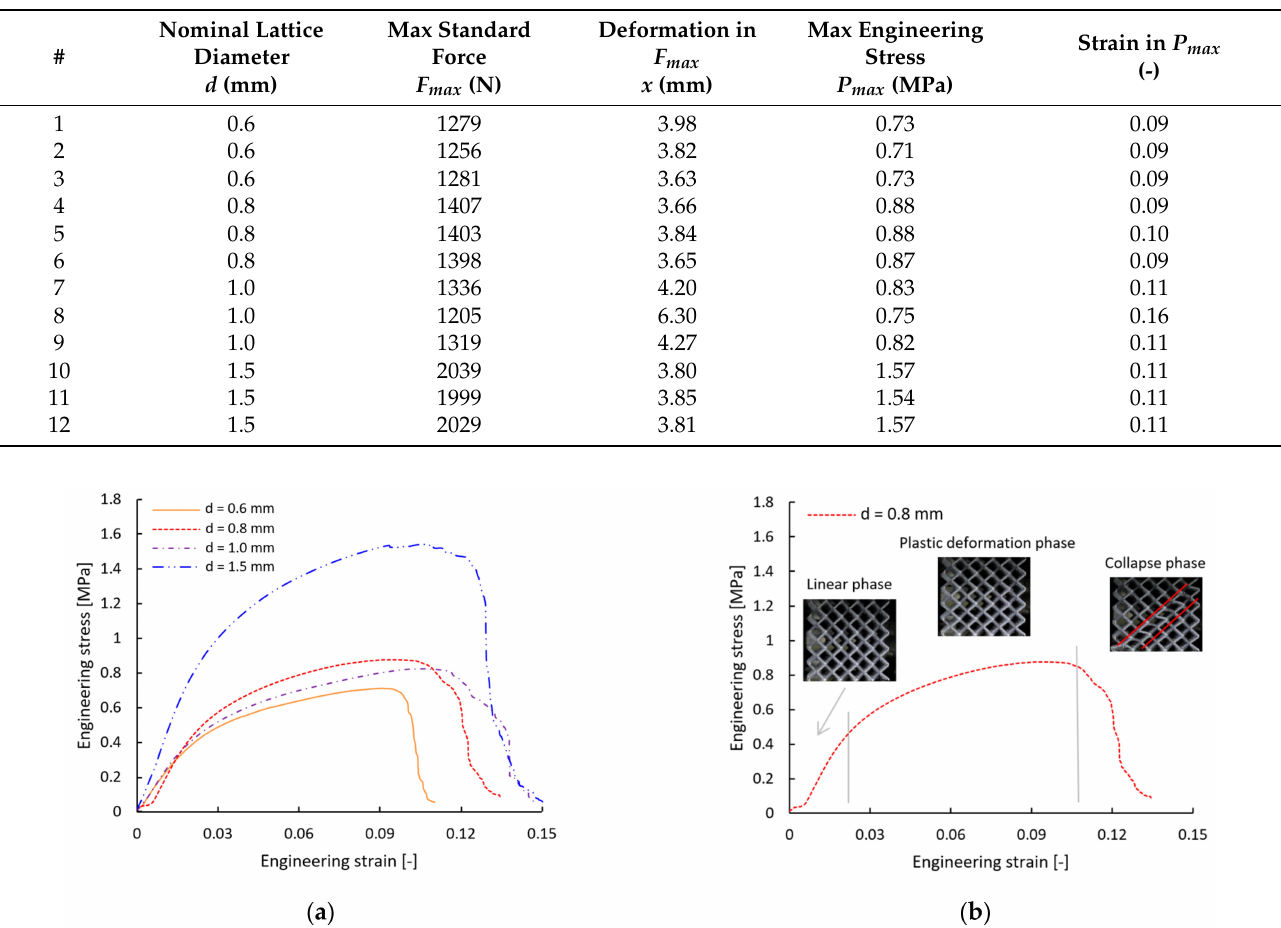
Table 2. The results of the experimental mechanical testing of BCC lattice structure cubes.